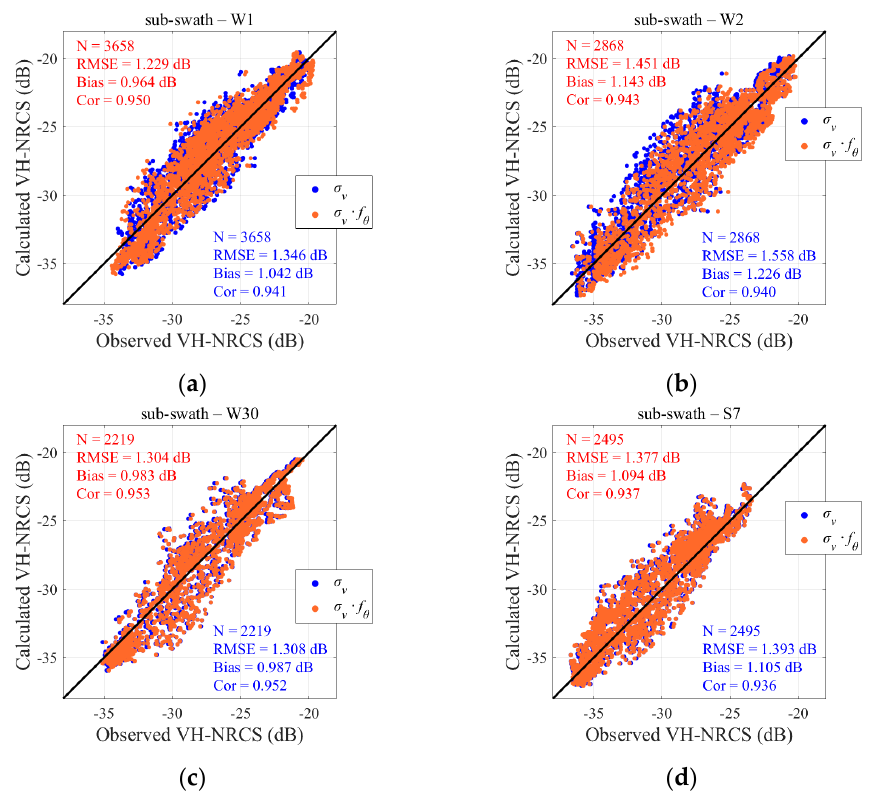
Figure 11. NRCS before and after correction using incidence angle model vs. NRCS observed by radar without NESZ on the sub-swaths ( a ) W1, ( b ) W2, ( c ) W30, and ( d )